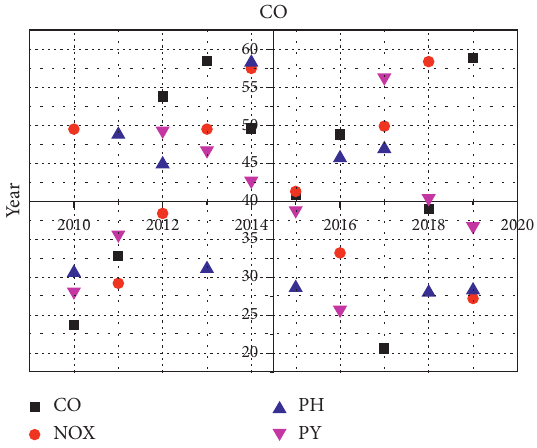
Figure 5: Results under different factors. Figure 6: Statistics of travel time distribution of typical activity modes.